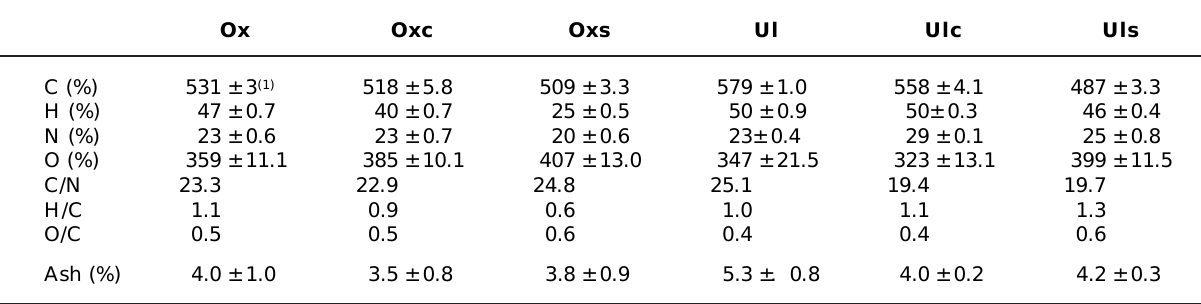
(1) Standard mean